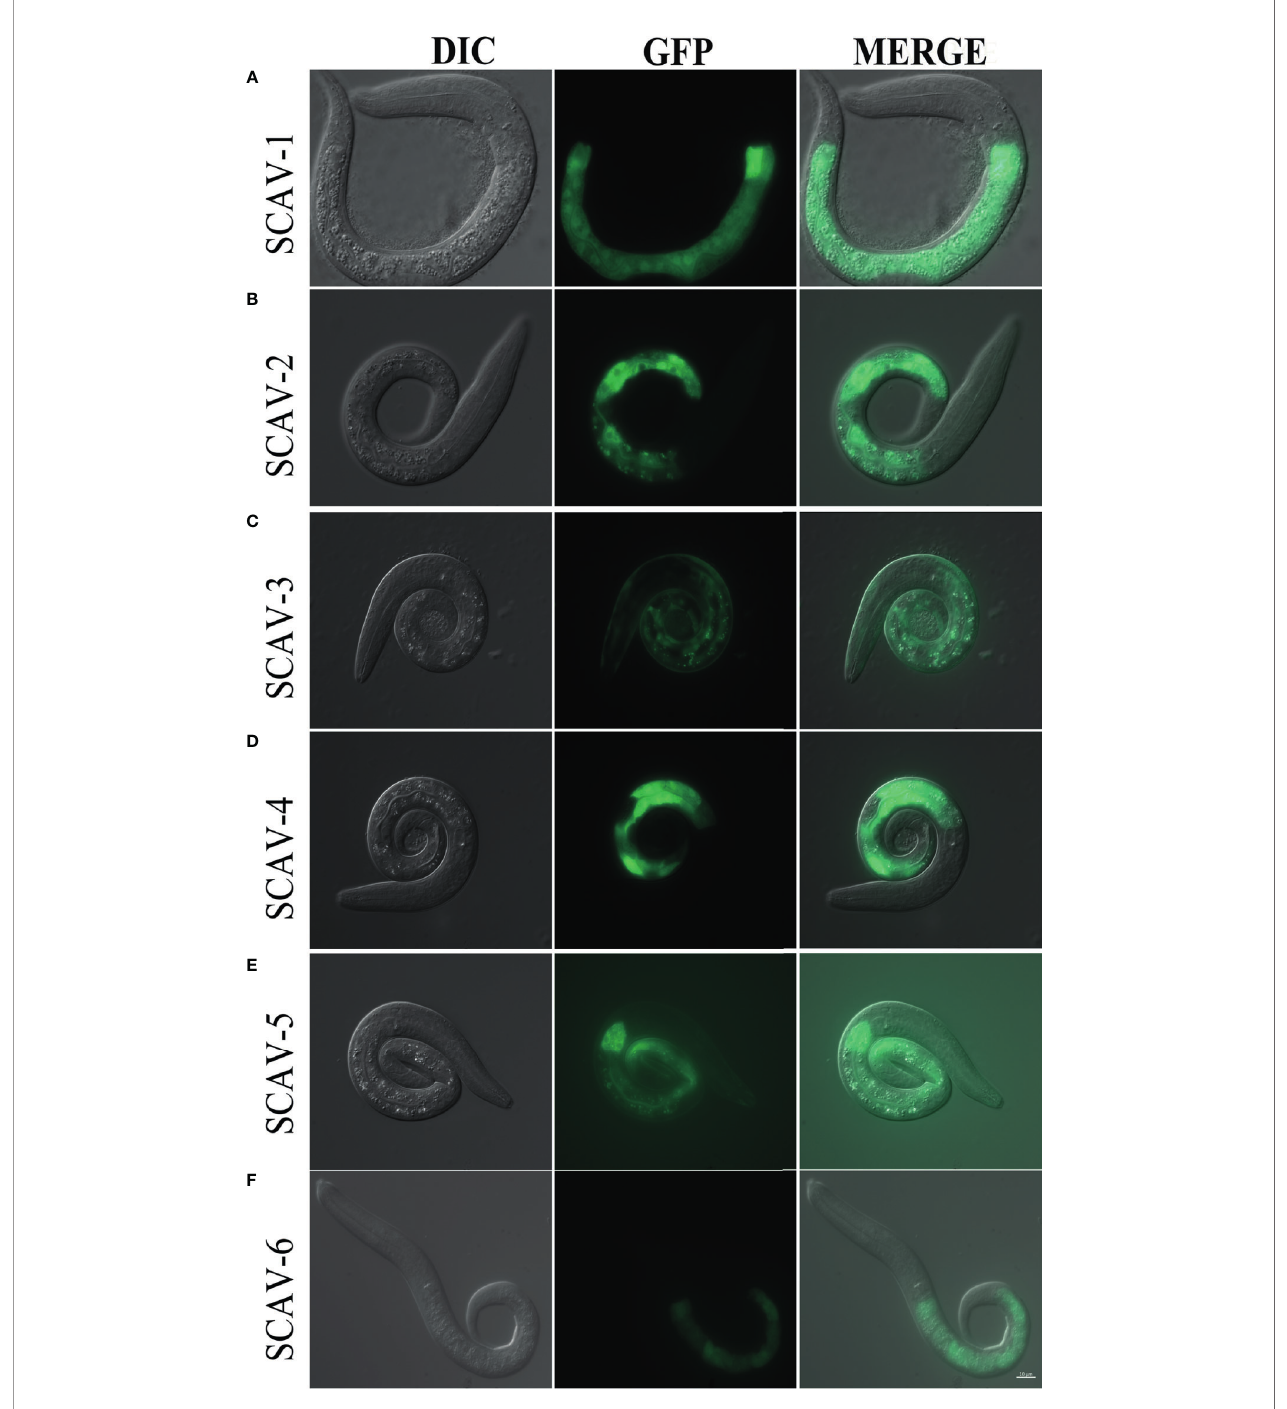
FIGURE 1 | The expression pattern of scavenger receptors in C.elegans . (A – F) : Tissue pro fi ling of scavenger receptor SCAV-1-6. DIC images of L1 stage live transgenic animals (left). Green fl uorescence images show tissue localization of scavenger receptor SCAV-1-6 (middle). Merge images (right). Scale bar=10 m